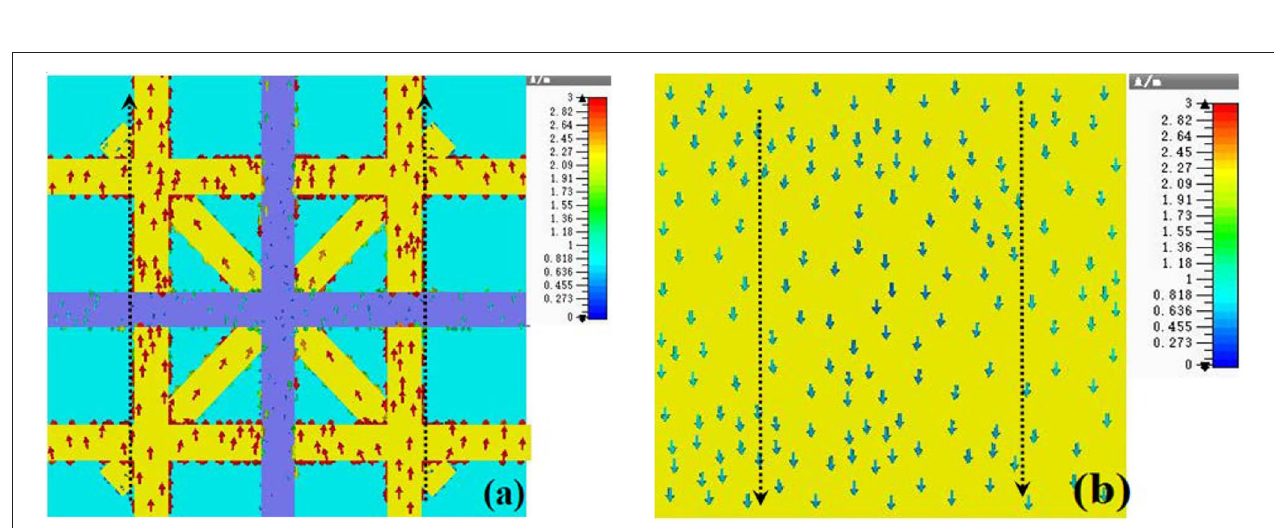
FIGURE 8 | (a,b) The surface current distribution of the metamaterial absorber at 5 GHz with the Fermi level of graphene at 0eV.